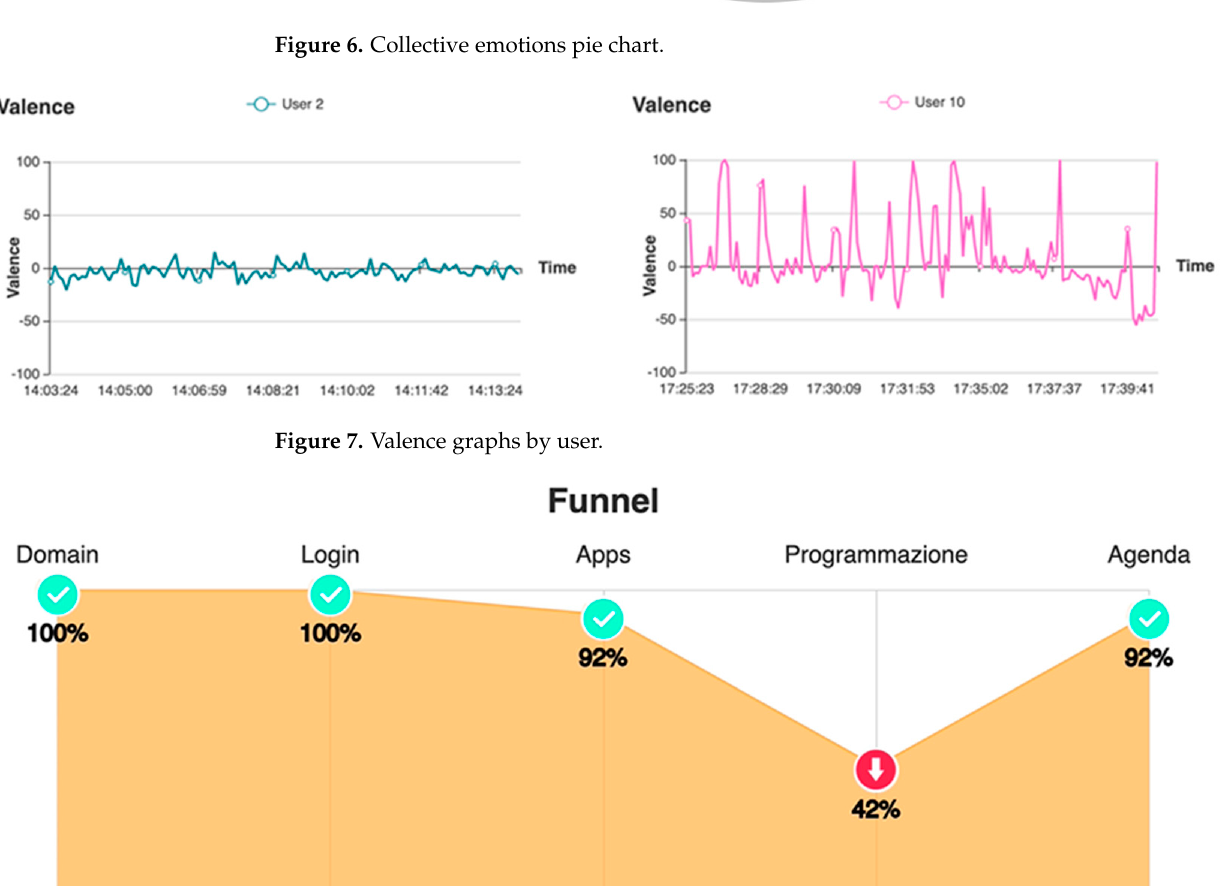
Figure 6. Collective emotions pie chart.